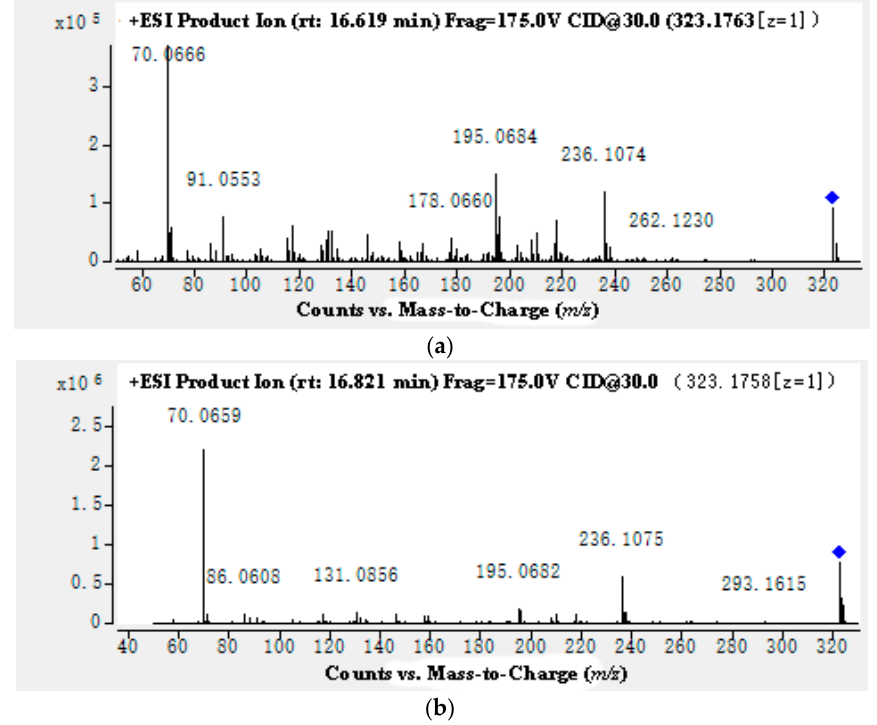
Figure 2. The MS/MS spectra of compound 1 ( a ) and 2 ( b ).